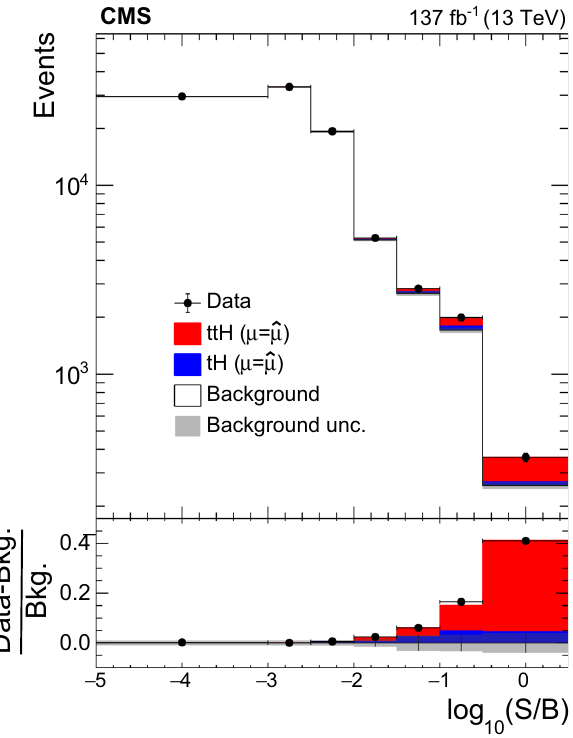
Fig. 13 Distribution of the decimal logarithm of the ratio between the expected ttH + tH signal and the expected sum of background contri- butions in each bin of the 105 distributions that are included in the ML fit used for the signal extraction. The distributions expected for signal and background processes are computed for ˆ μ ttH = 0 . 92, ˆ μ tH = 5 . 7, and the values of nuisance parameters obtained from the ML fit The distributions that are included in the ML fit are shown in Figs. 8, 9, 10, 11 and 12. In the 2 (cid:4) SS + 0 τ h and 3 (cid:4) + 0 τ